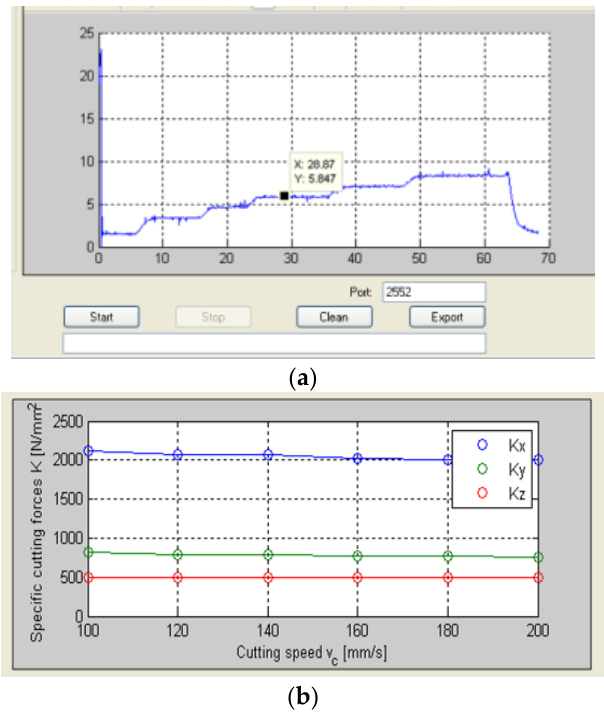
Figure 12. ( a ) Power measurements; ( b ) Specific cutting coefficients in Cartesian directions. Table 1. Lathe/workpiece modal parameters.